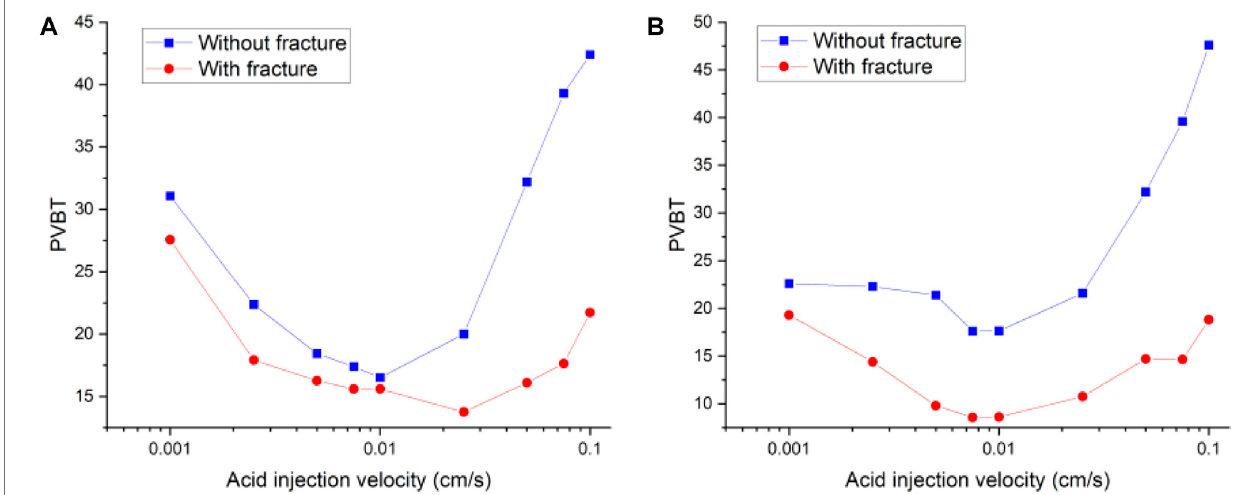
FIGURE4| Comparison ofacidizingcurves ofpore volumetobreakthroughbetweenmatrixandisolatedfracture: (A) Stokes – Darcyequation; (B) Darcy equation.